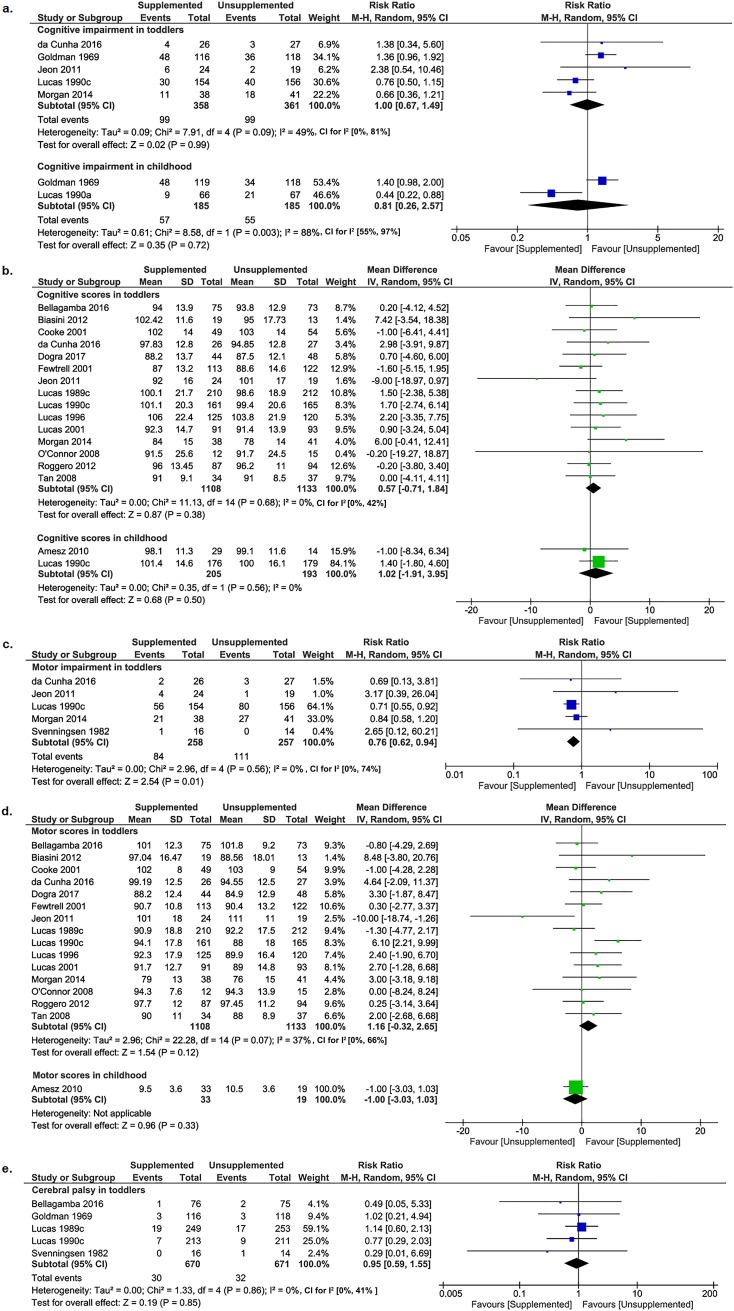
Forest plots of effect of macronutrient supplementation on primary and secondary developmental outcomes.(a) Cognitive impairment (primary outcome); (b) cognitive scores; (c) motor impairment; (d) motor scores; (e) cerebral palsy (all secondary outcomes). Blue boxes in the forest plots represent the dichotomous data; green boxes represent the continuous data. CI, confidence interval; M-H, Mantel-Haenszel; IV, inverse variance.